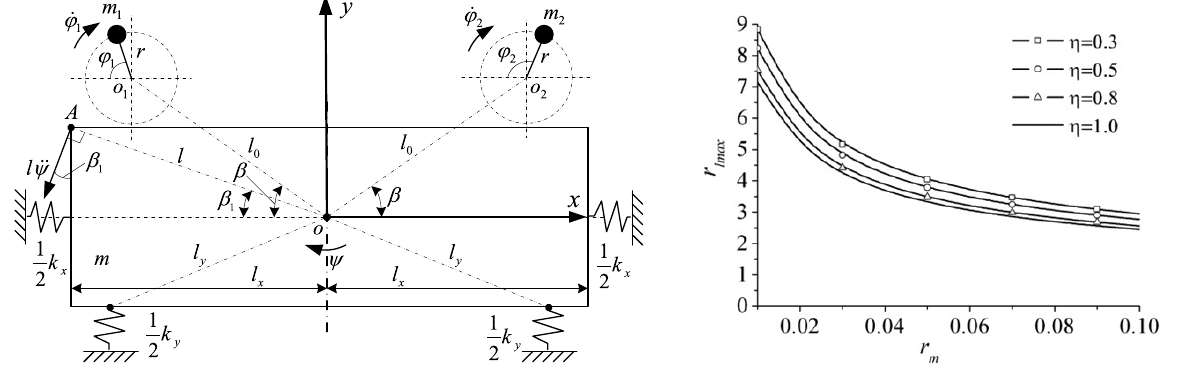
Fig. 1. Dynamic model of a vibrating system with the two homodromy exciters. Fig. 2. The maximum of r 2 l